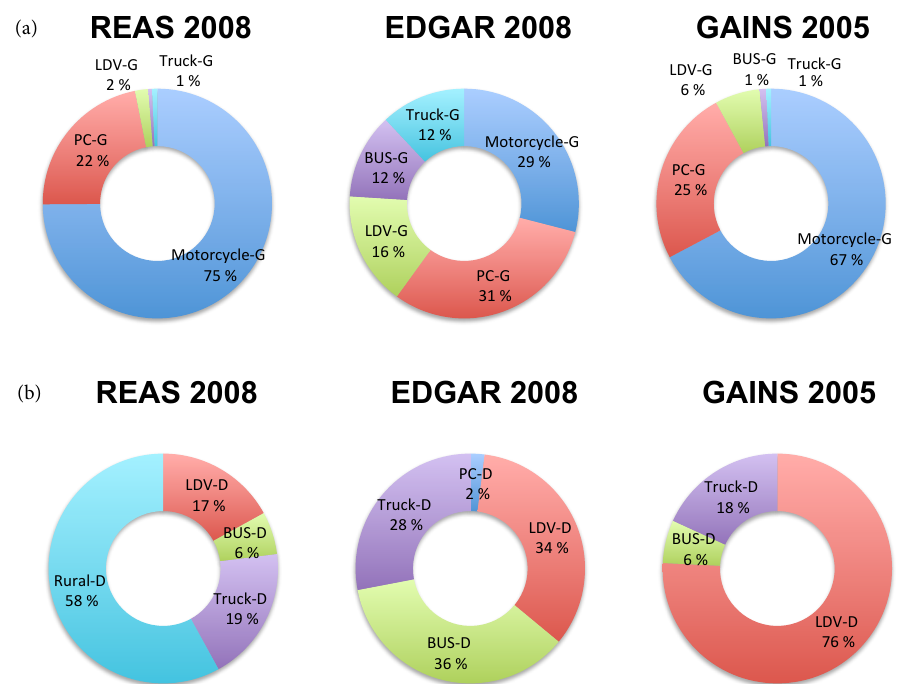
Figure 10. (a) Contribution of each of the vehicle categories to the number of gasoline vehicles. (b) Contribution of each of the vehicle categories to the number of diesel